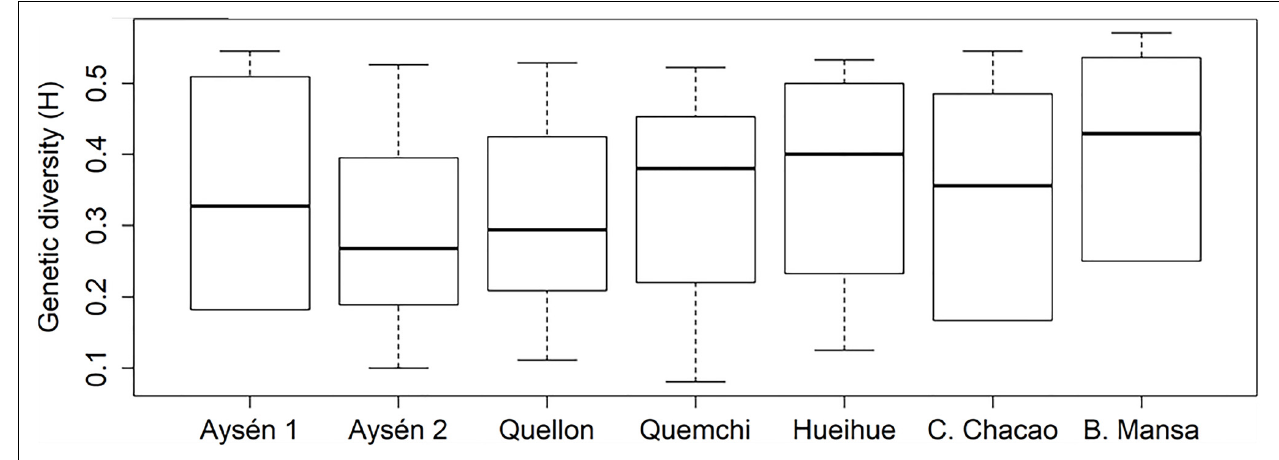
FIGURE 3 | Genetic diversity boxplot of A. catenella populations (GLMM, p >